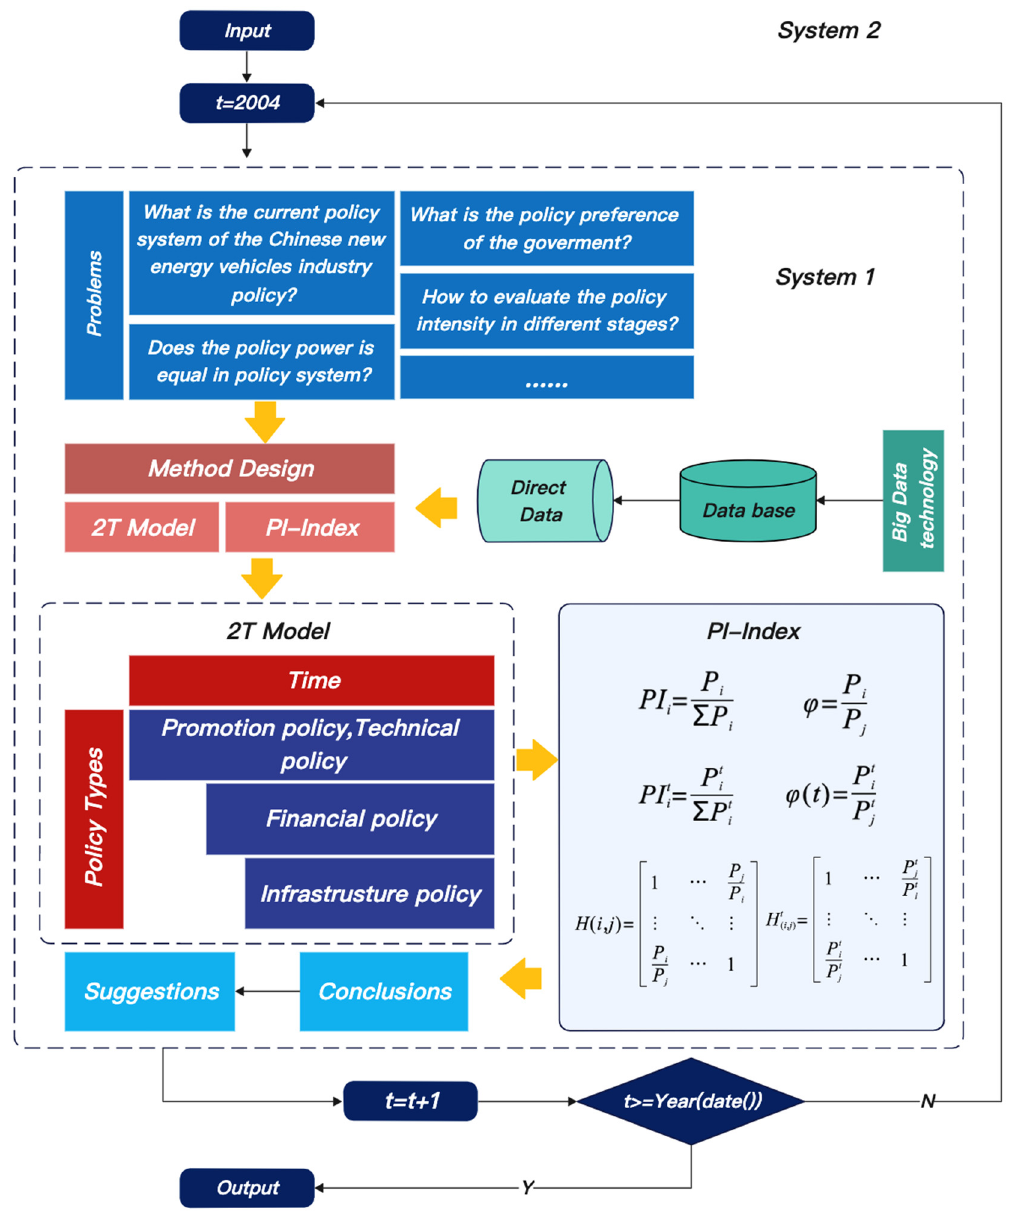
Figure 1. The research